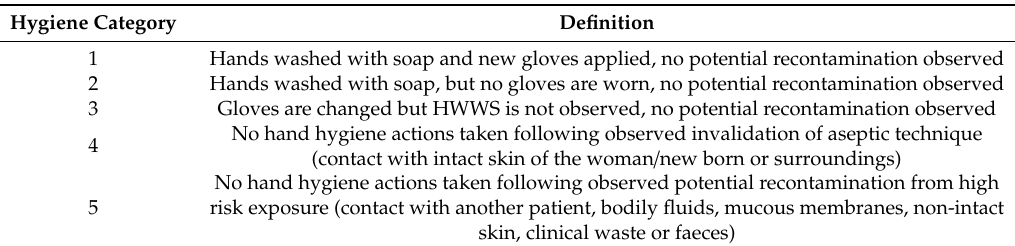
Table 1. Hand hygiene categories used in